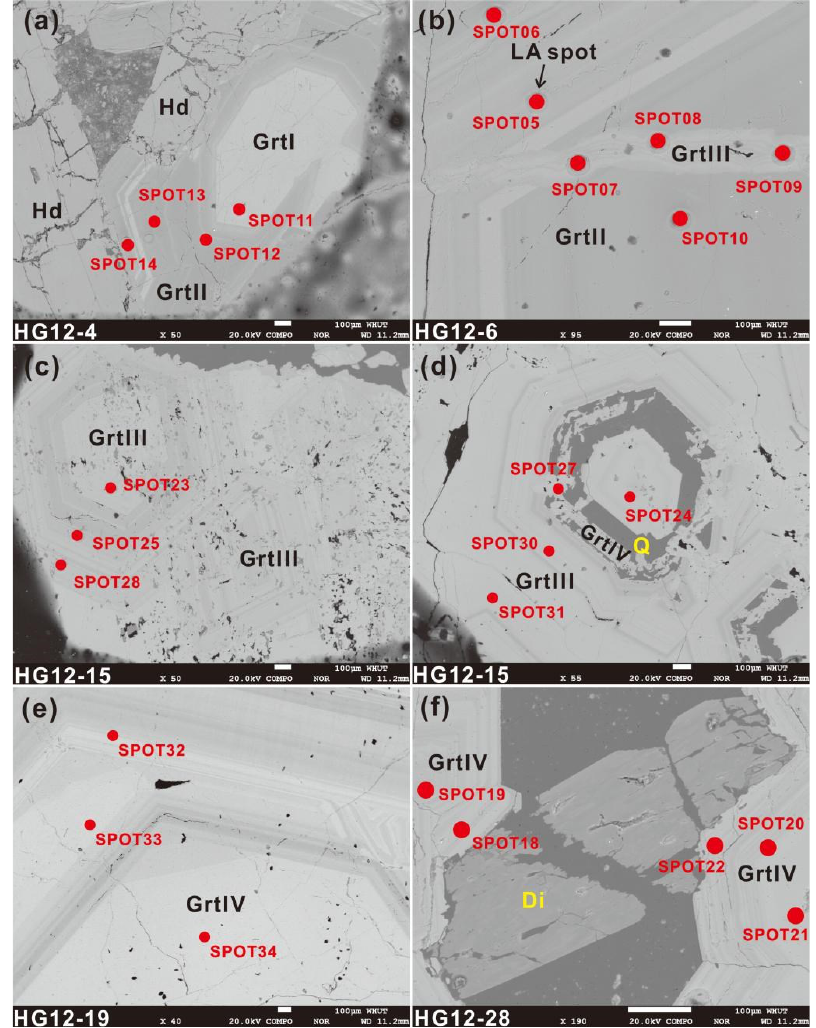
Figure 6. Back-scattered electron (BSE) images of the garnets from the Huanggang deposit. ( a ) The garnet (sample HG12-4) showing the isotropic core (Grt I) and oscillatory zoned rim (Grt II). ( b ) The garnet (sample HG12-6) exhibiting the oscillatory zoning of garnet (Grt II) cut by garnet veins (Grt III). ( c , d ) The garnet (Grt III) displaying the obvious core–rim texture, whose alteration of garnet is serious, and also replaced by later irregular residual garnet (Grt IV). ( e , f ) The garnet (Grt IV) exhibiting obvious core–rim texture, and also intergrown with diopside. Mineral abbreviations: Grt, garnet; Hd, hedenbergite; Q, quartz; Di,